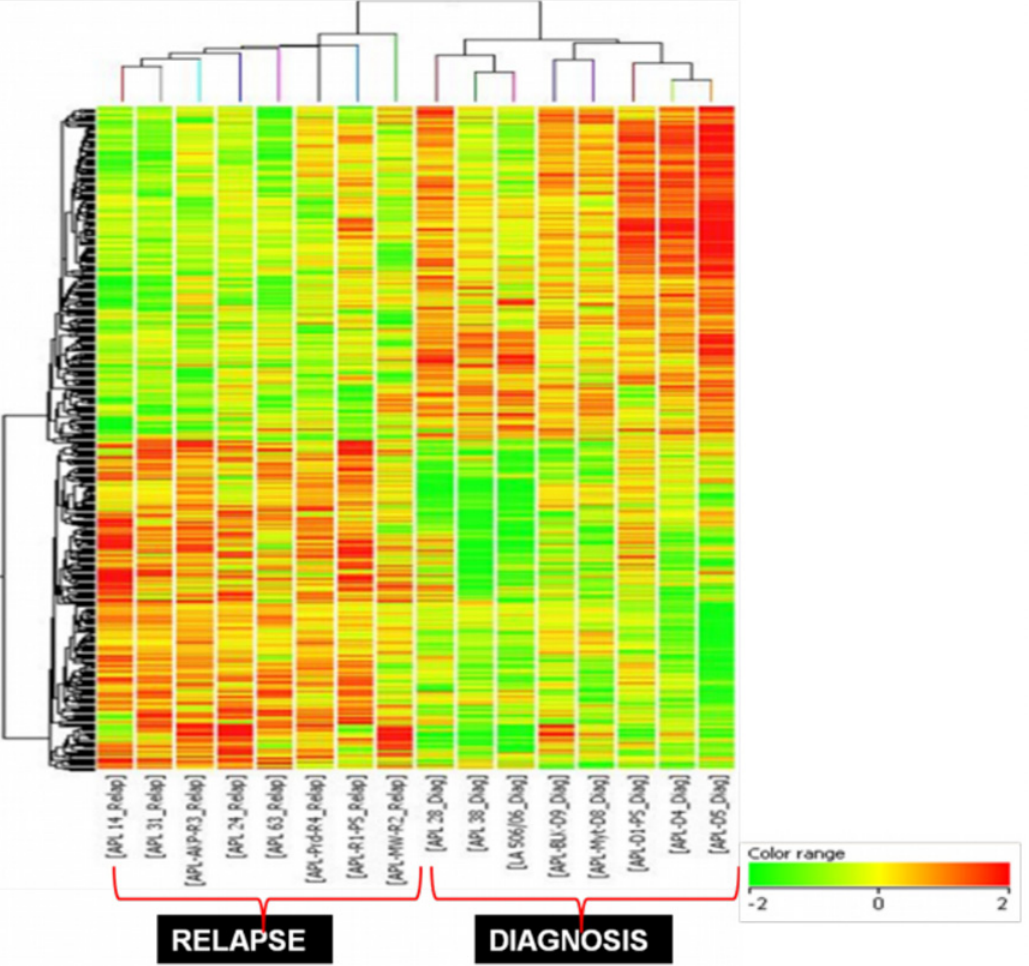
Fig 4. Differential gene expression profile of relapsed Vs. newly diagnosed patients with Acute Promyelocytic Leukemia. The expression profile of eight unmatched relapsed versus newly diagnosed acute promyelocytic leukemia samples. The cluster diagram represents > 2 fold significantly differential gene list of 864 up regulated (red) and 880 down regulated genes (green). The ratios are color coded as indicated in the bar. The complete gene list and annotations are given in the supplementary section (S1 Dataset). doi:10.1371/journal.pone.0121912.g004 Table 3. Differentially regulated genes in relapsed cases classified into biological functional groups based on the gene ontologies using Gene Spring and Biointerpretor software (Agilent Technologies). Functional